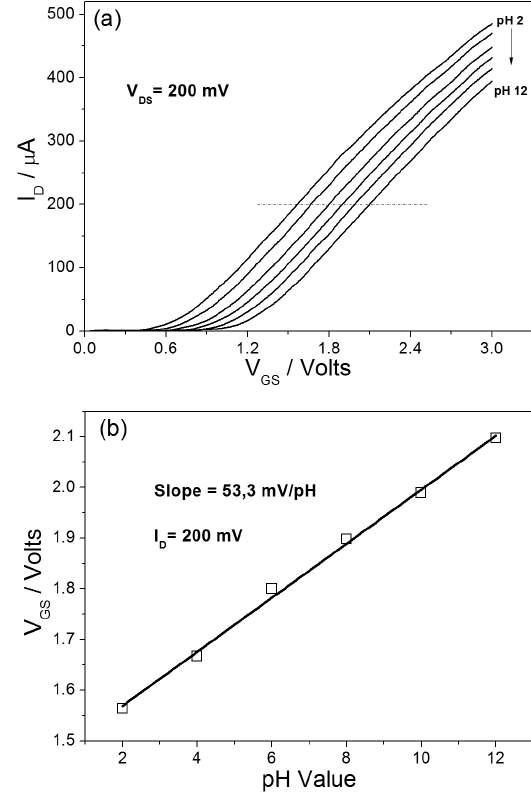
Figure 6. I -V characteristics for constant V D GS of the ITO film as separative extend gate-FET in the pH range from 2 to 12: (a) I GS -V characteristics, and (b) sensitivity calculated when I D DS . 200 µ D